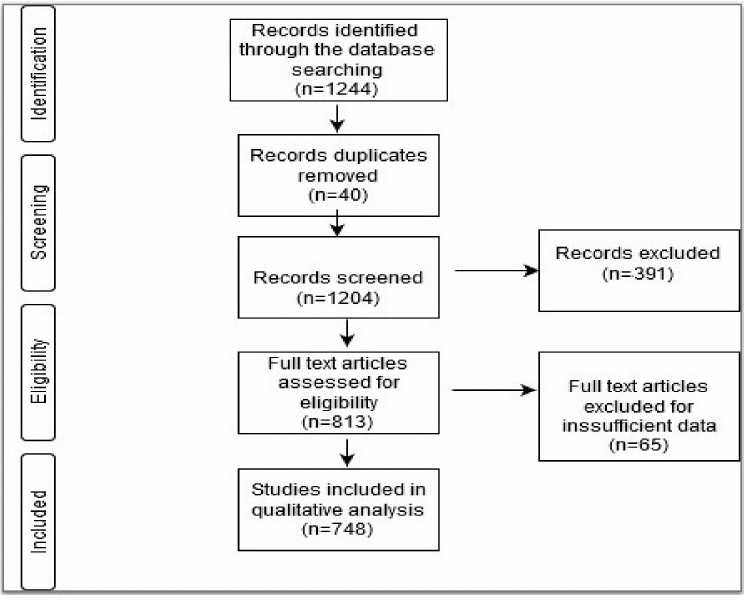
Figure 2. SLR according to Prisma methodology.